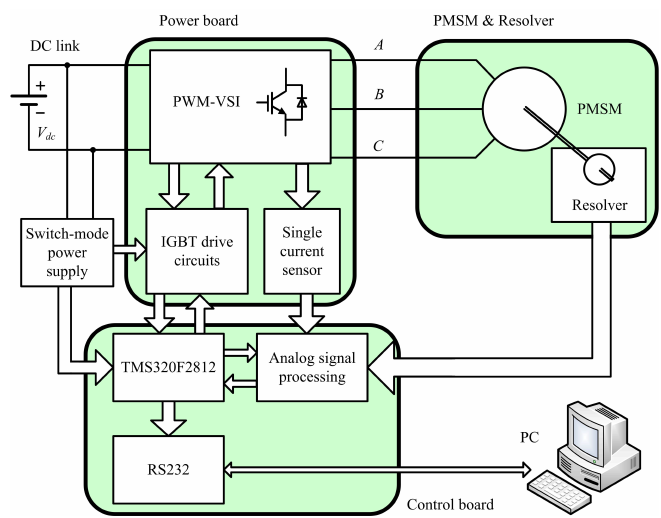
Figure 8. Scheme of the experimental setup.